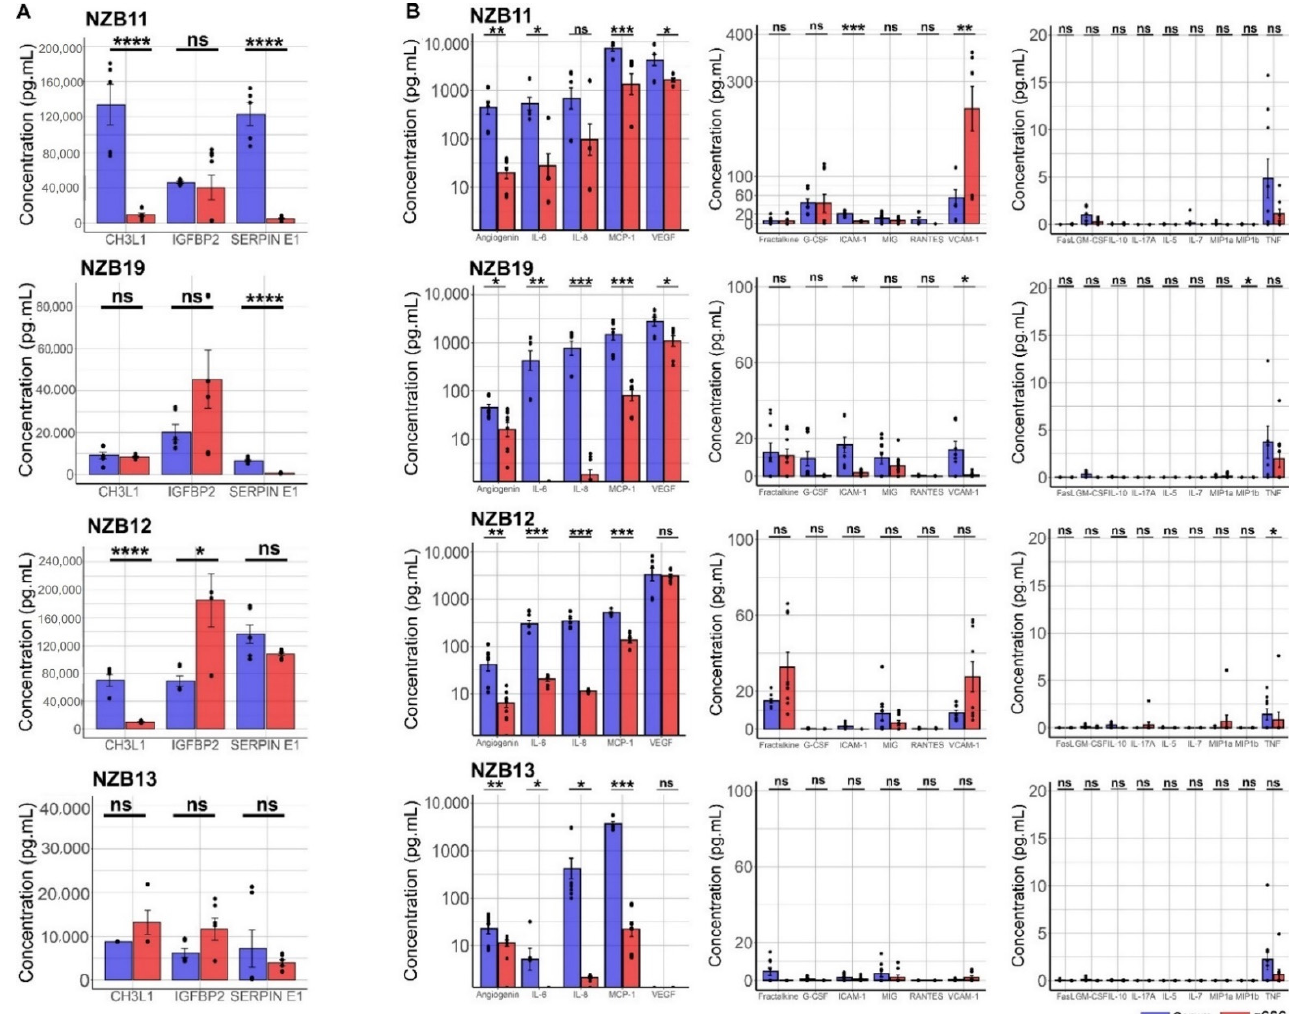
Figure 4. Concentrations of secreted immune-modulators in 4 glioblastoma cell lines. ( A ) Luminex based analysis of CHI3L1, IGFBP2 and Serpin E1 concentrations in NZB11, 12, 13, and 19 cell lines cultured in serum or as stem-like cells. ( B ) Cytometric bead array analysis of selected cytokines and chemokines concentrations in NZB11, 12, 13 and 19 cell lines cultured in serum or as stem-like cells. The results of three independent experiments are shown. Unpaired students t -test analysis was carried out. p -value = 0.05 (*), 0.01 (**), 0.001 (***), 0.0001(****), and ns means not